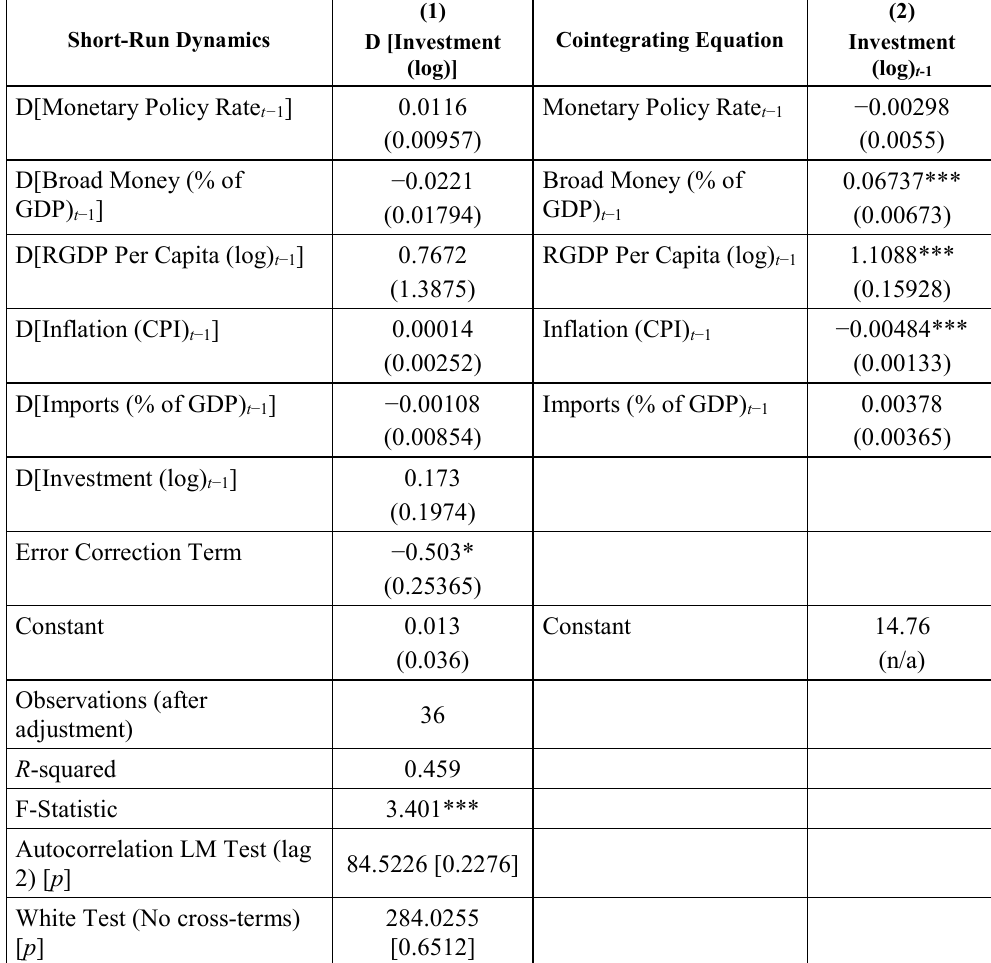
Table 6. Regression Result (Main